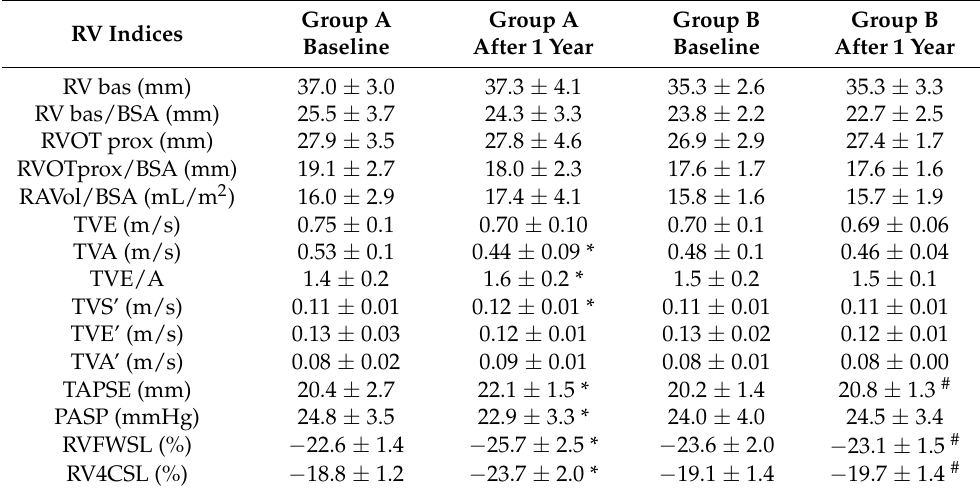
Table 3. The echocardiographic data of the RV anatomy and function of both groups at the baseline and after one year 1 .